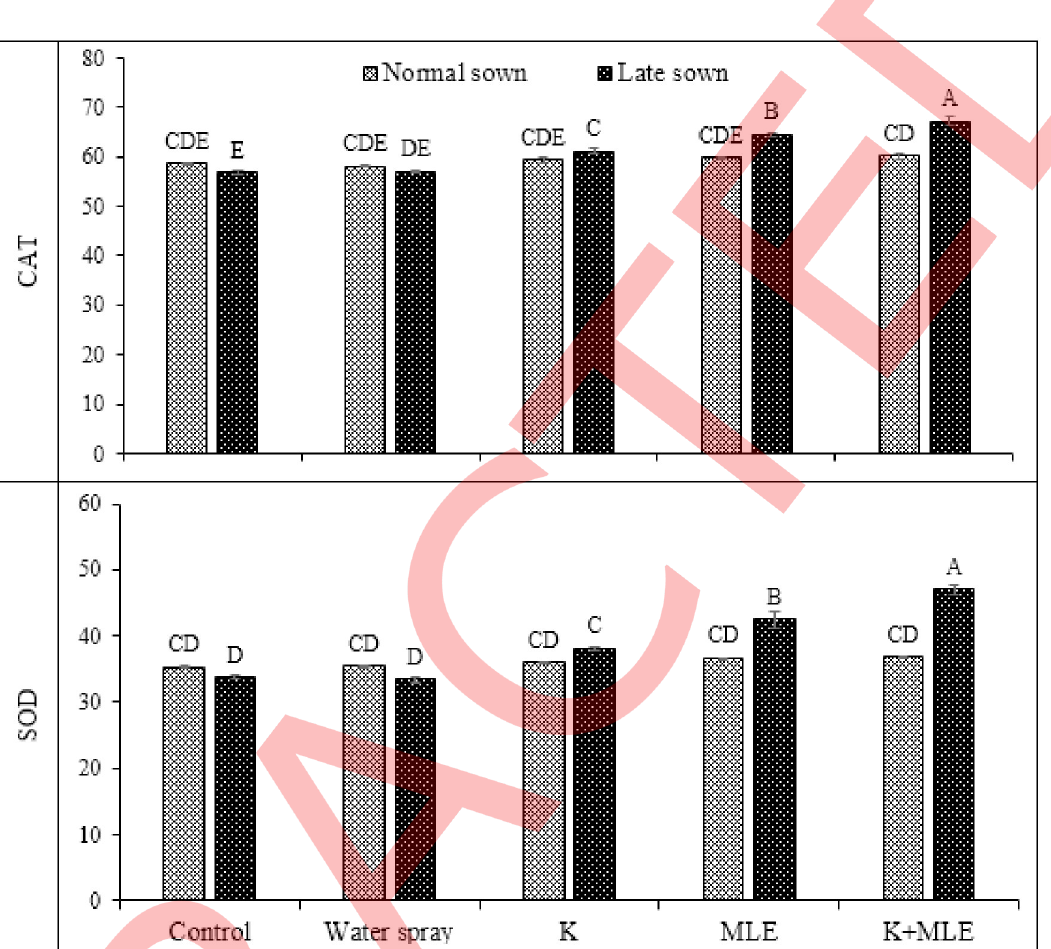
Fig 4. Impact of foliar applied K and MLE on CAT and SOD activities of early and late sown kabuli